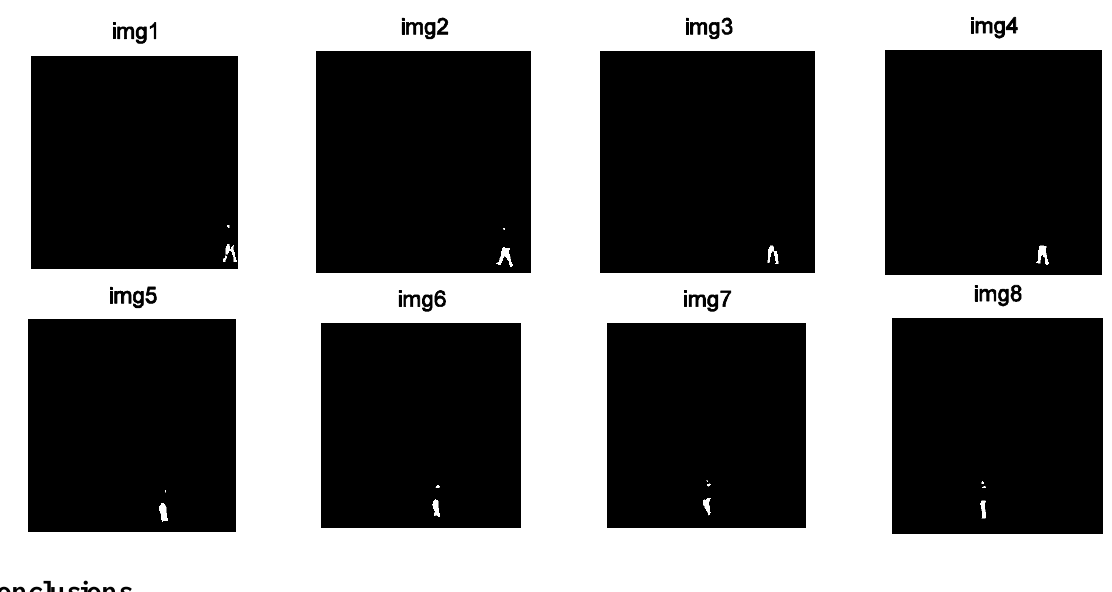
Figure 10. Sequence of images detected to determine a new object from those captured in Figure